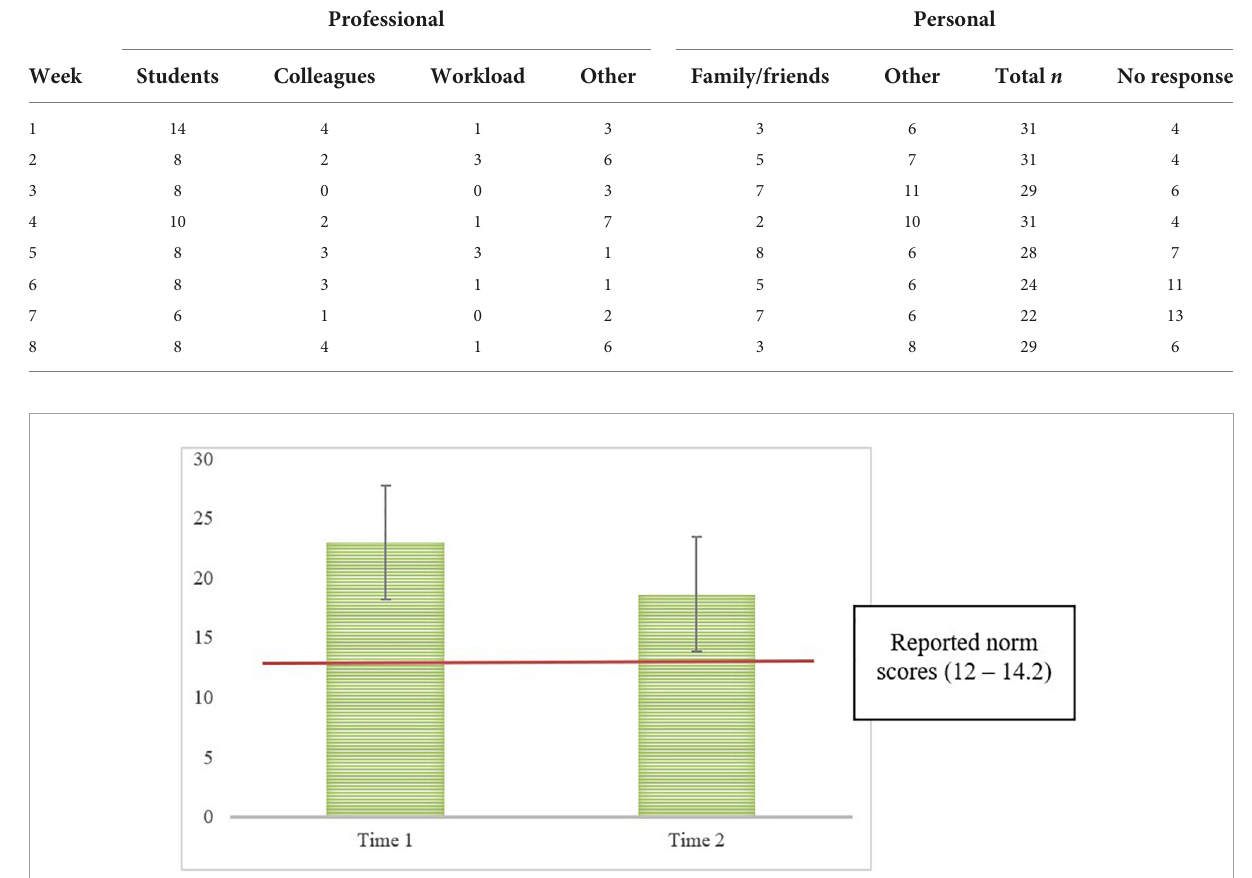
FIGURE2 Change in perceived stress compared to general population matched on age. Time 1 (pre-program) and Time 2